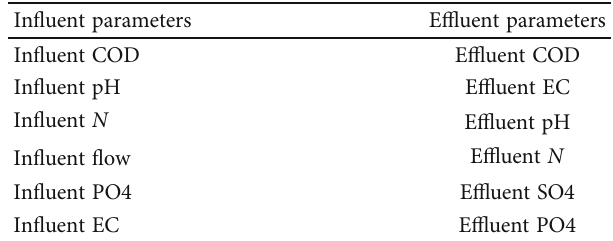
Algorithm 5: Prediction and evaluation BKNN-ELM (proposed). Table 2: Selection of parametric values.